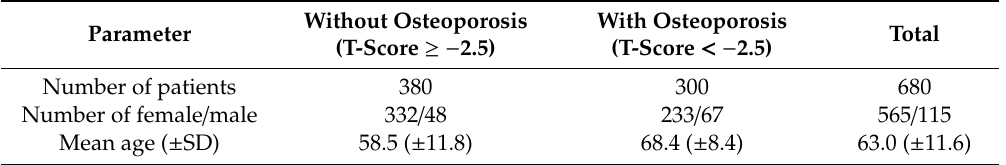
Table 1. Clinical and demographic characteristics of the dental panorama radiographs (DPRs) dataset in this study.